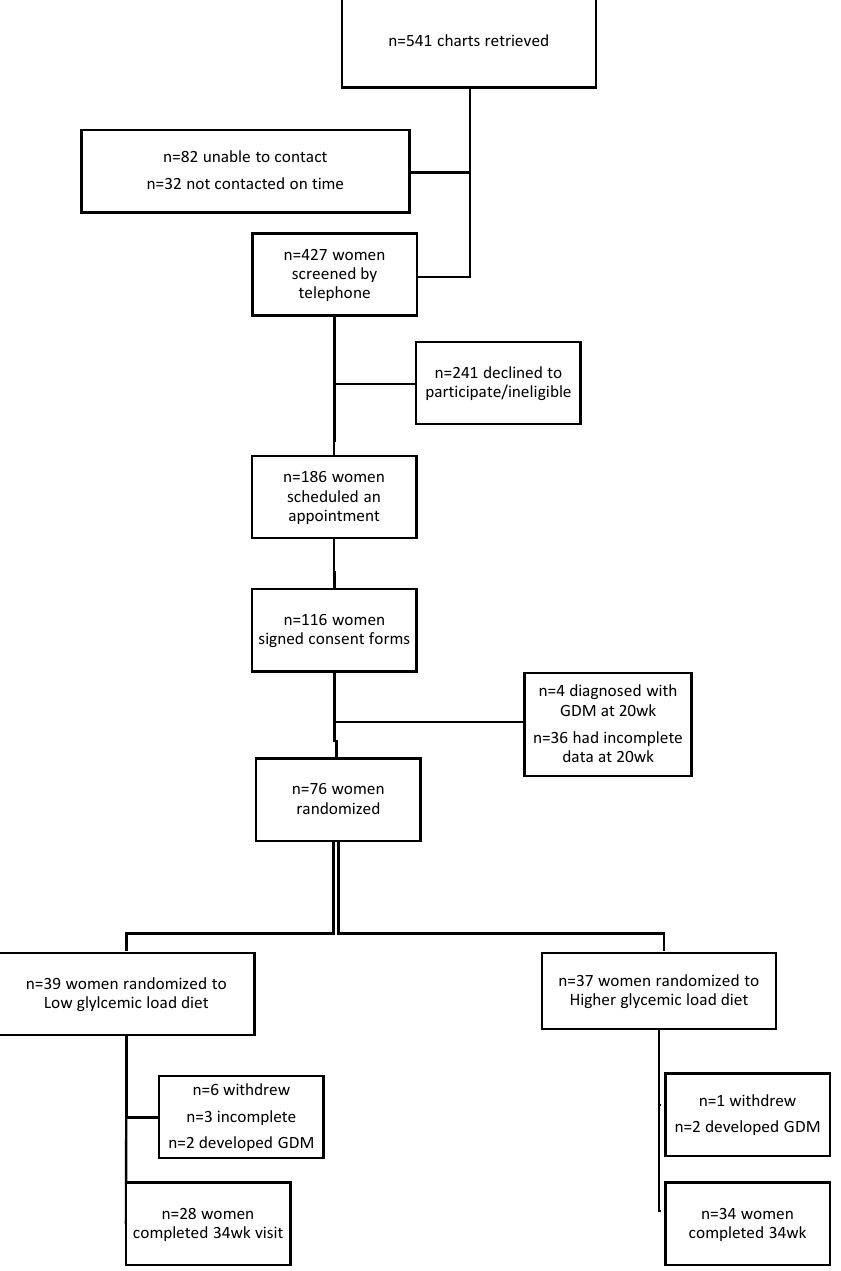
Figure 1. Flow chart participant recruitment and enrollment .